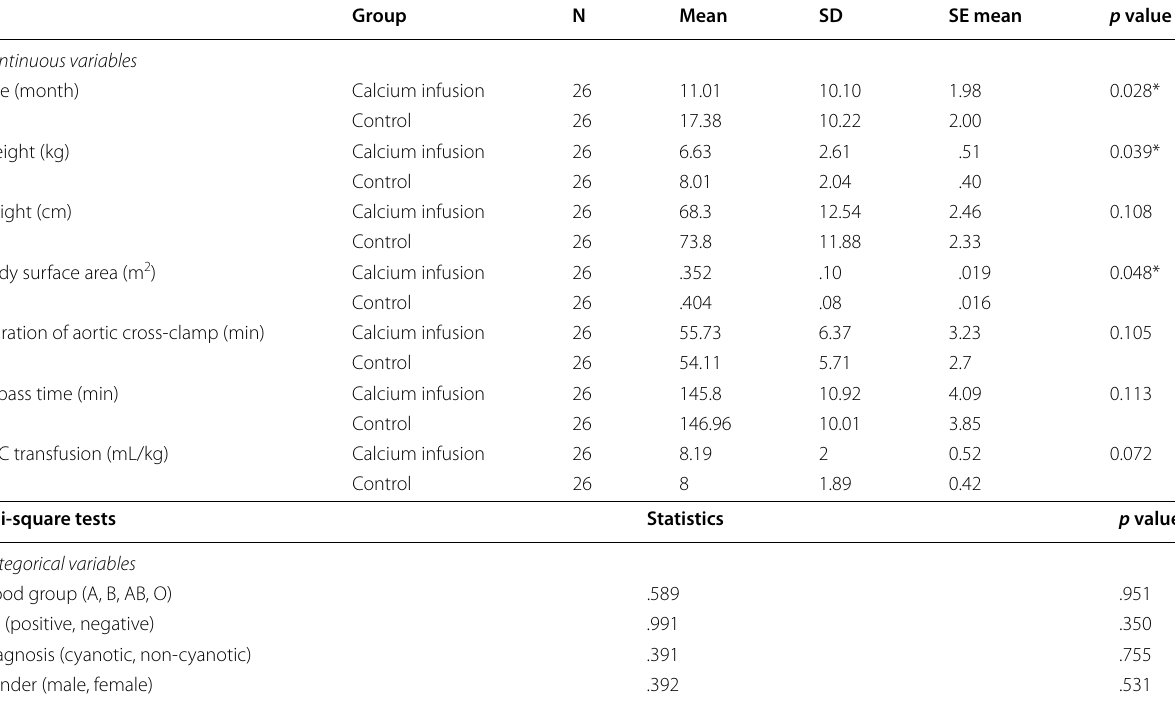
Table 2 Descriptive statistics of demographic